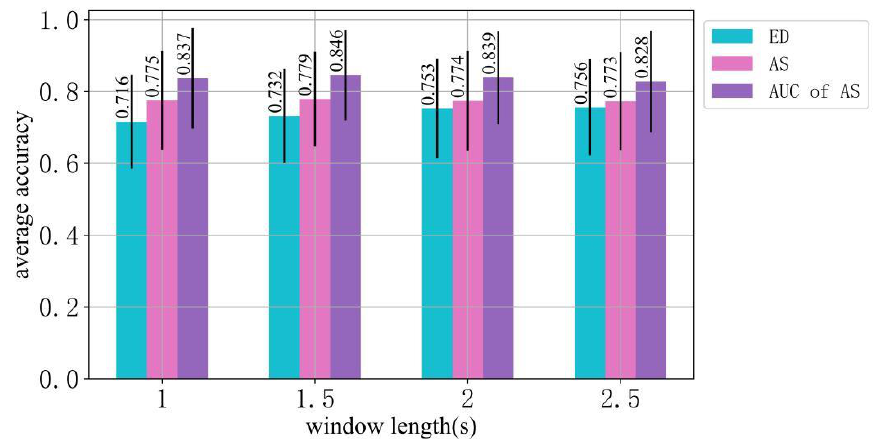
Figure 9. The comparison of the average classification accuracy and AUC value distribution using the ED and AS algorithms for the features extracted from 11 cropped windows (n = 11), each of which is 1 s/1.5 s/2 s/2.5 s in length.